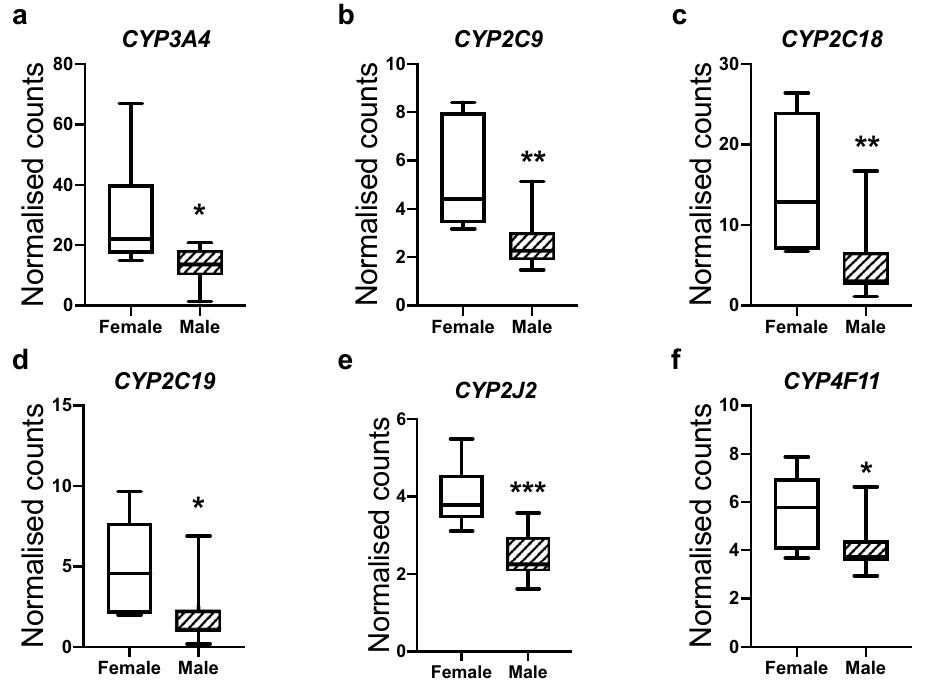
Figure 2. Sexually dimorphic expression of genes involved in progesterone and xenobiotic metabolism in fetal female (n = 6) and male (n = 11) livers at day 90 of gestation. Data represent RNAseq normalised gene counts. These data resulted from a separate study involving detailed hepatic analysis. Box plot whiskers are lowest and highest observed values, box is the upper and lower quartile, with median represented by line in box. Unpaired, two-tailed Student’s t test was used for comparing means of two treatment groups with equal variances accepting P < 0.05 as significant (* P < 0.05, ** P <